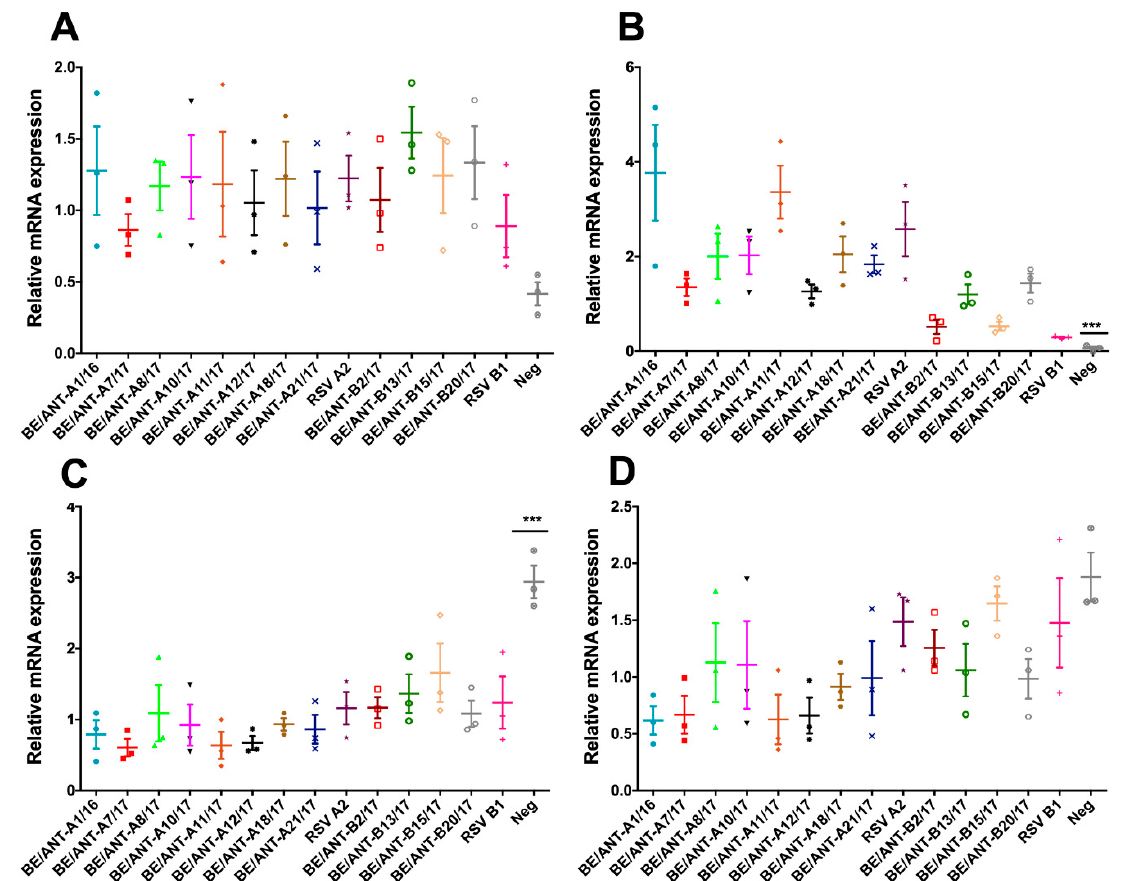
Figure 8. mRNA levels of mucins 1, 4, 5AC and 5B in infected A549 cells. A549 cells were infected with a MOI of 0.1 of clinical isolates and reference strains for 2 h at 37 °C. Inoculum was replaced with DMEM-10 and cells were incubated for 48h at 37 °C. Afterwards, cells were lysed, total RNA was extracted and the expression of MUC1 ( A ), MUC4 ( B ), MUC5AC ( C ) and MUC5B ( D ) was determined by qRT-PCR. Data represents mean values ± SEM ( n = 3), statistically significant differences compared to the reference strains are indicated with *** p < 0.001 (one-way ANOVA) .